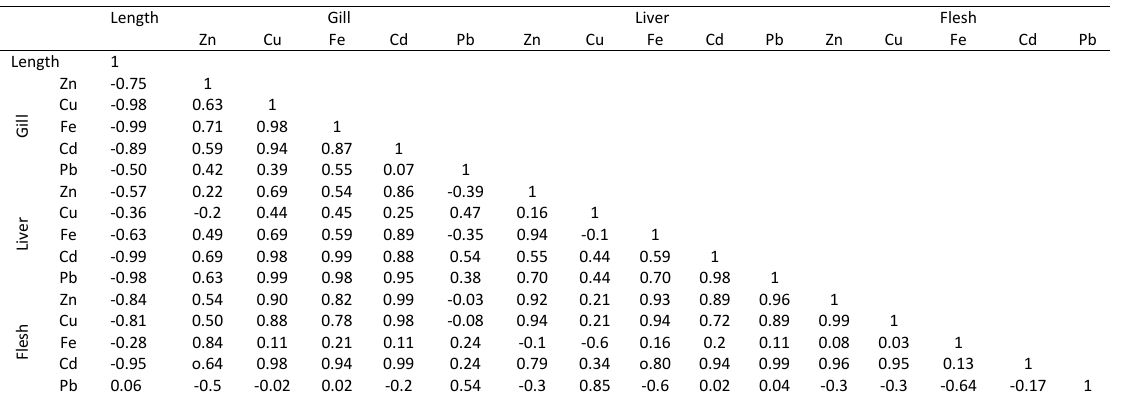
Table 4: Relationships between inter metal levels in various organs and fish sizes Table 4. Relationships between inter metal levels in various organs and fish